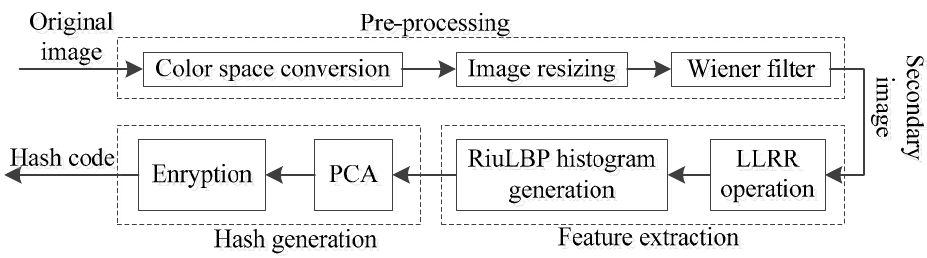
Figure 1. The perceptual image hashing (PIH) scheme, based on latent low rank representation (LLRR) and rotation invariant uniform local binary patterns (RiuLBP).